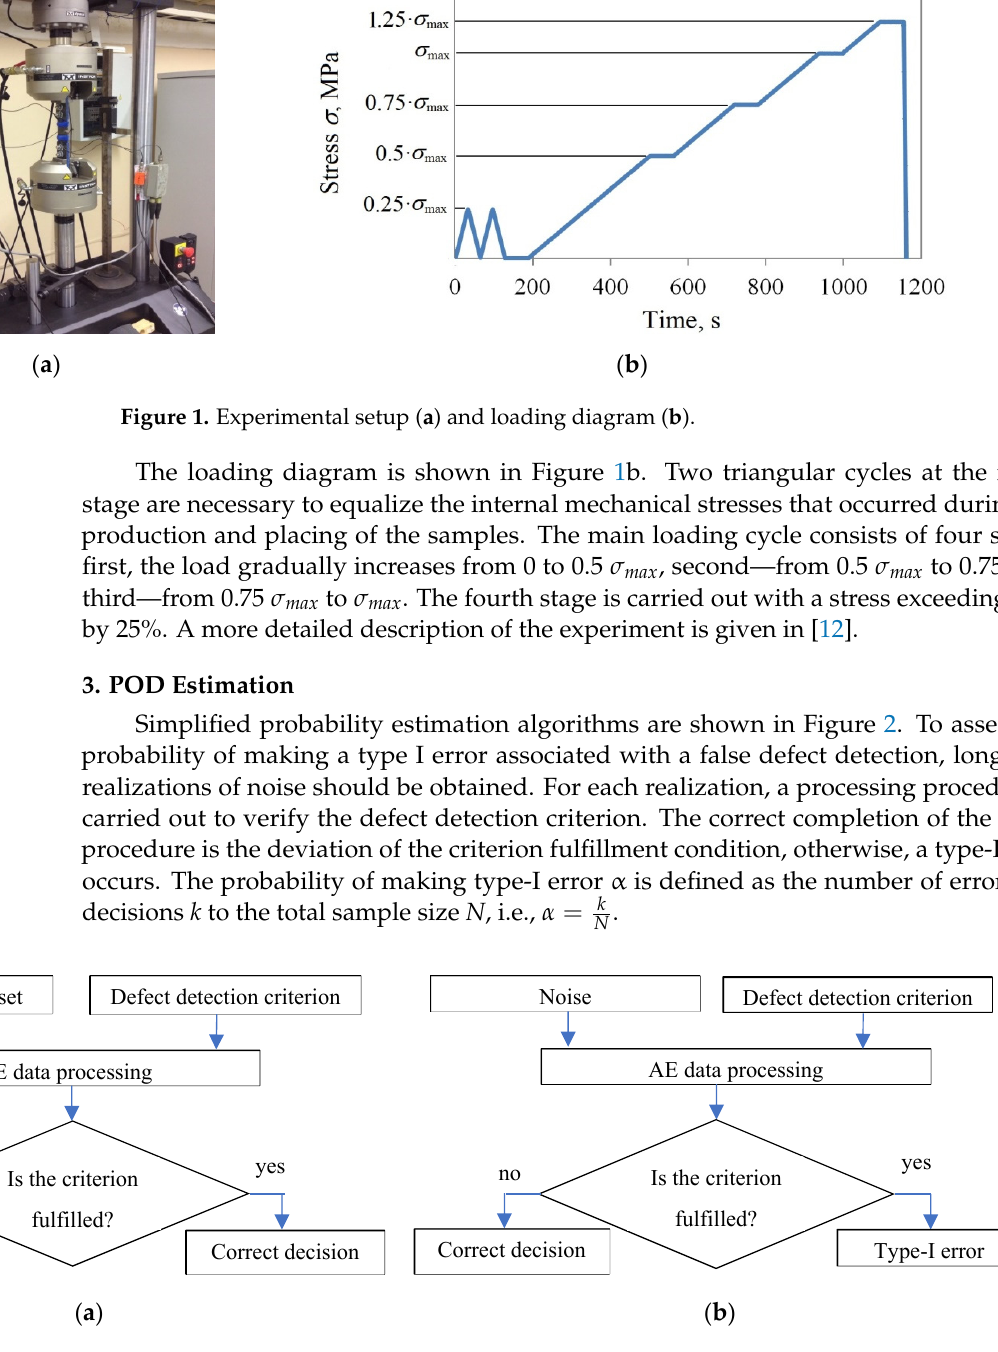
Figure 2. Simplified algorithms for estimating the probability of making a type I ( a ) and type II ( b ) errors.